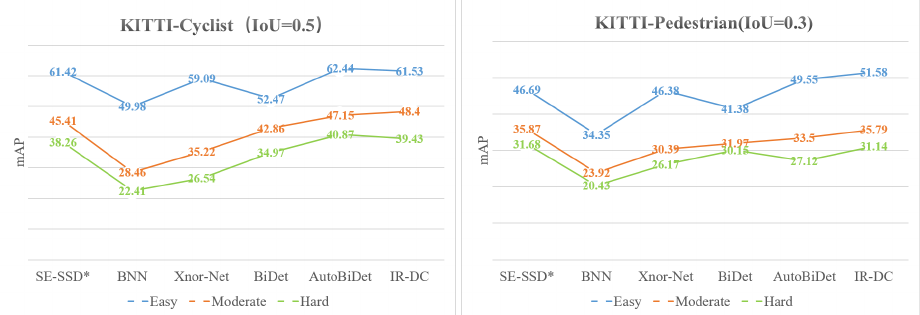
Figure 8. The results of a different quantitative method in the KITTI dataset (Cyclist and Pedestrian).